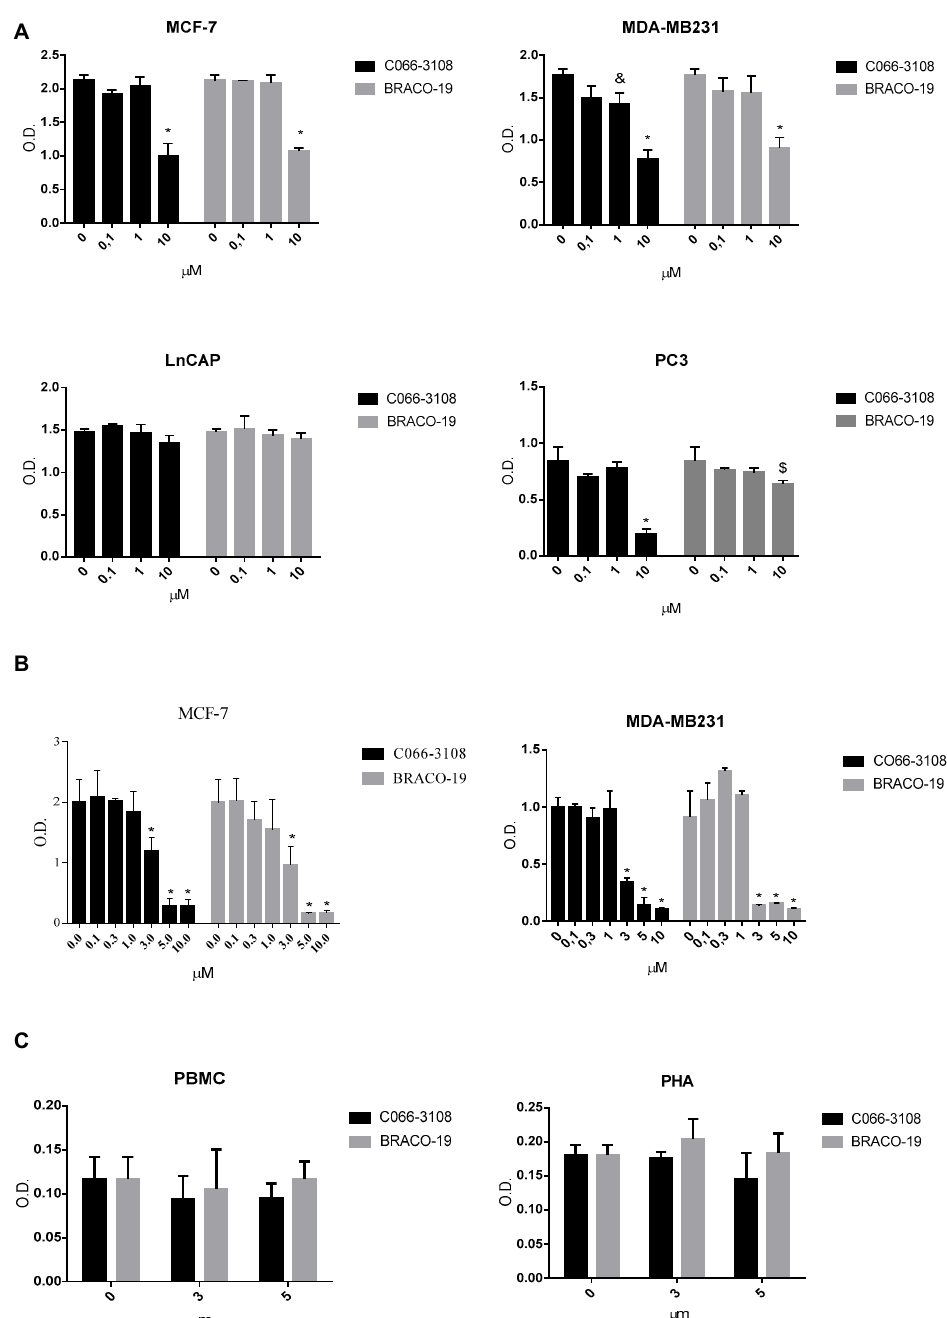
Figure 2. Cytotoxic effects of G4 ligands. ( A ) Cytotoxic effect of G4 ligands determined by SRB assays in MCF-7, MDA-MB231, PC3 and LNCaP cell lines at 72 h of treatment with C066-3108 and BRACO-19 and ( B ) in MCF-7 and MDA-MB231 cells at six days of treatment. Figures report cell viability (mean of three independent experiments as optical density, O.D.) generated with different concentrations of G4 ligands. The statistical significance was calculated by GraphPad Prism 7 with two-way Analysis of Variance (ANOVA) using Dunnett’s multiple comparisons test (* p < 0.0001, & p < 0.005, $ p < 0.01). ( C ) Survival determined by MTT assay of resting and/or PHA-activated PBMC cultured in the presence and in the absence of G4 ligands at the concentrations of 3 and 5 µM for 5 days. Figures report O.D. indicative of cell survival (data are the mean of three independent experiments). No statistical difference was observed with respect to the untreated control as calculated by GraphPad Prism 7.